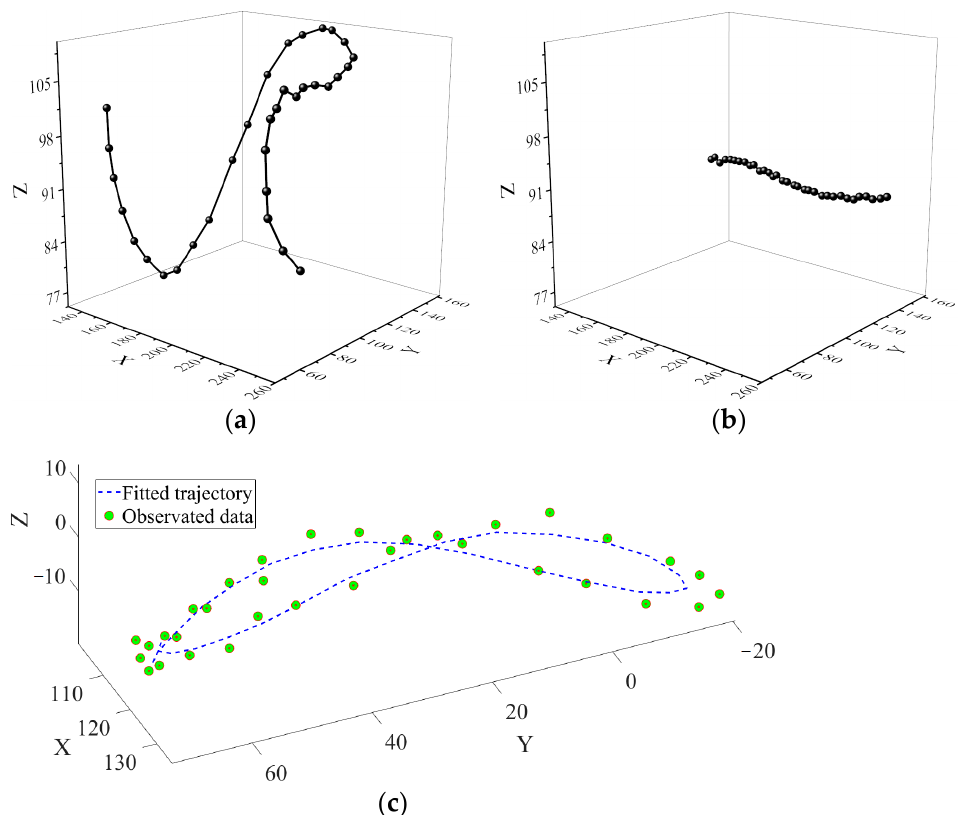
Figure 4. Three-dimensional kinematics data. ( a ) is the data of the toe. ( b ) is the data of the shell’s center. ( c ) is the trajectory of the toe relative to the shell’s center. The video of the biological observation is shown in the Supplementary Materials S1 and S2.